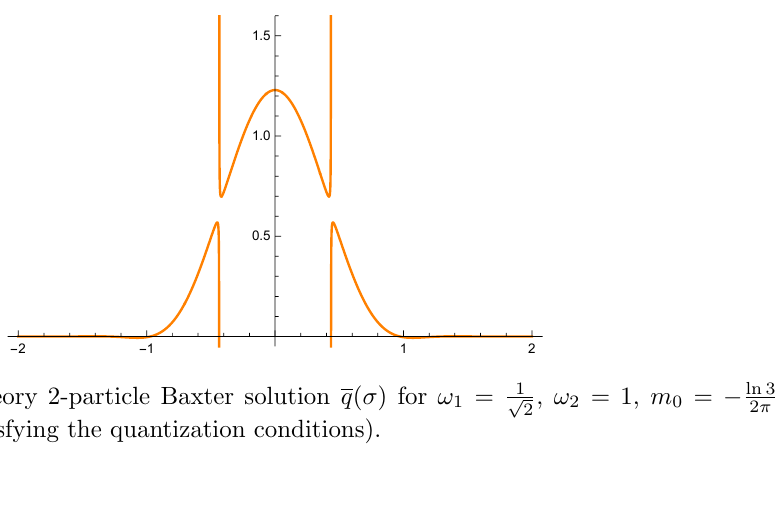
, ! 2 = 1, m 0 = (cid:0) ln3 at 2 (cid:25) 2